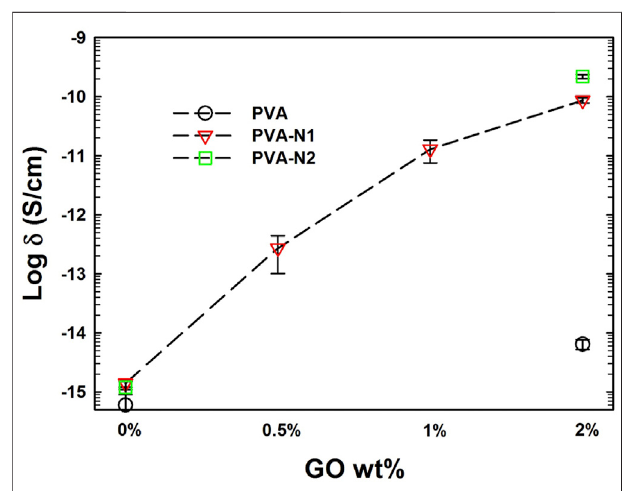
FIGURE 8 | Electrical conductivity of PVA, PVA-N, and their